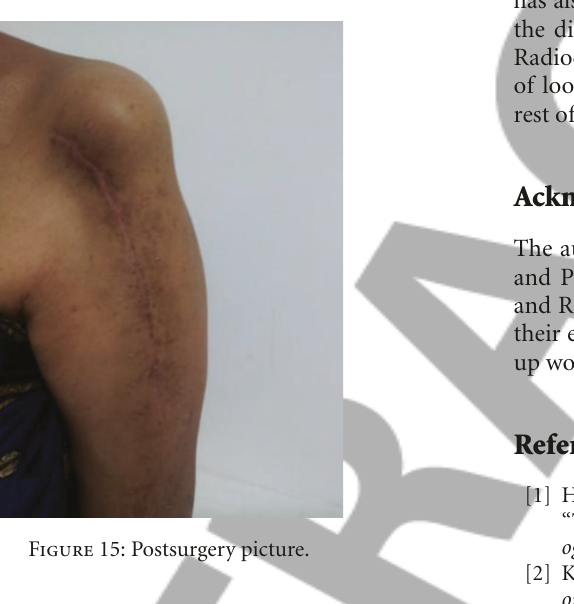
Figure 15: Postsurgery